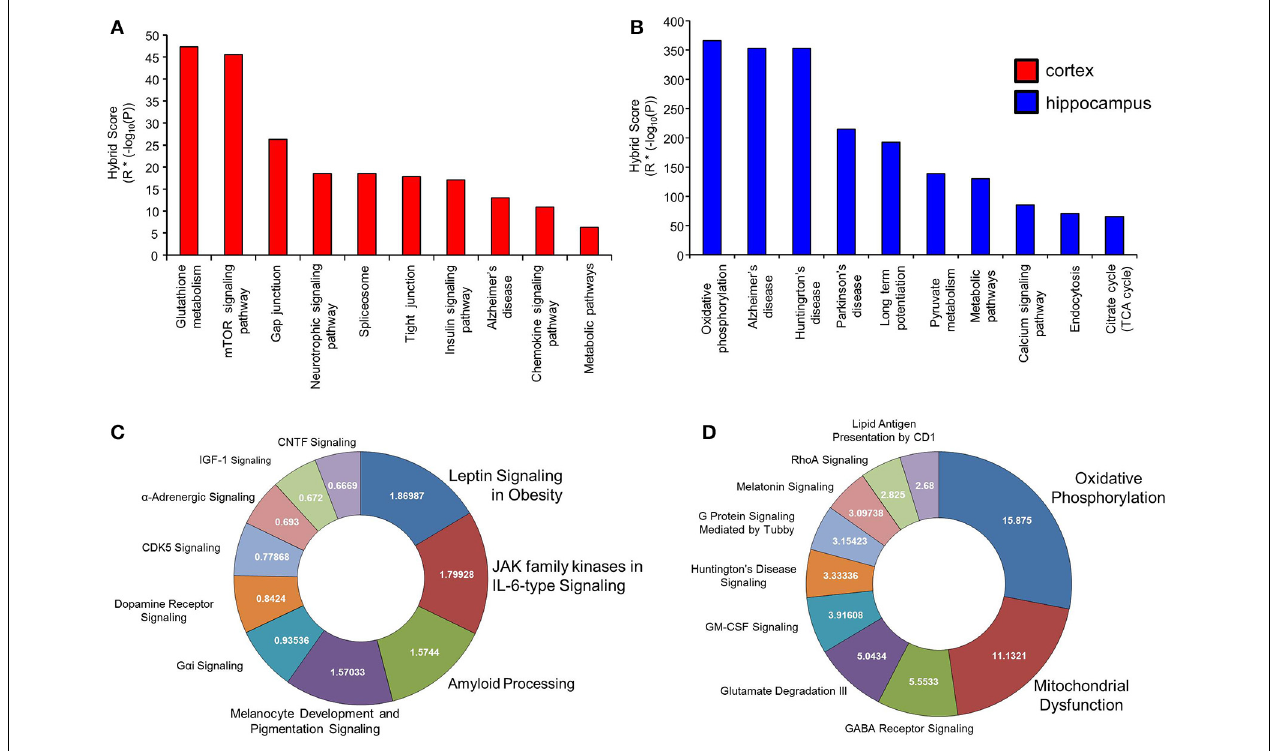
FIGURE 5 | Signaling pathway analysis of cortical and hippocampal proteins differentially regulated BTBR and WT. Cortical and hippocampal proteins exhibiting differential regulation between BTBR and control mice were analyzed for potential functional pathway interactions using KEGG ( A -cortex,